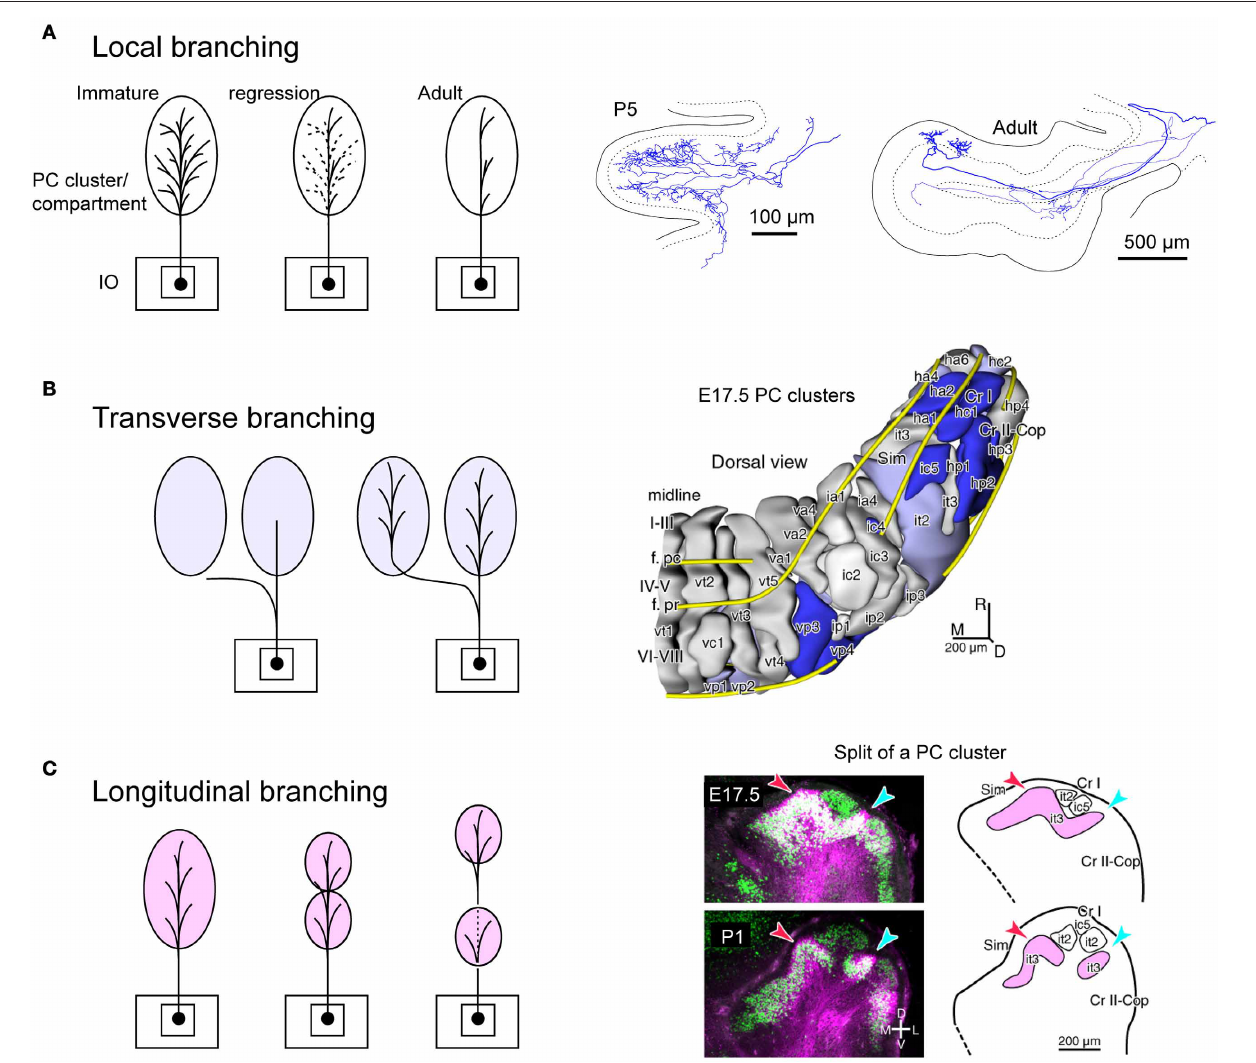
multiple clusters of PCs. Right-hand inset shows PC clusters in the E17.5 cerebellum (cited from Fujita et al., 2012). (C) Some longitudinal branching may be formed by longitudinal separation of a target compartment. Right-hand inset shows the longitudinal split of a PC cluster in the developing cerebellum (cited from Fujita et al., 2012). E17.5, embryonic day 17.5; P1 postnatal day 1; it2, ic5, it3, etc.; names of embryonic PC